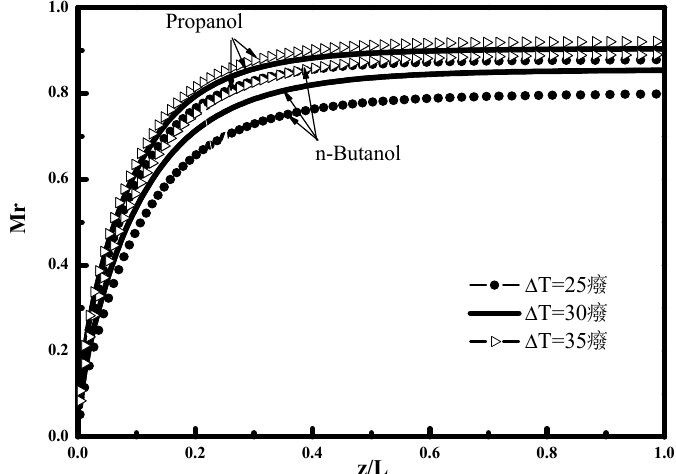
Figure 6. Variation of the condensation rate along the tube for different Δ T.